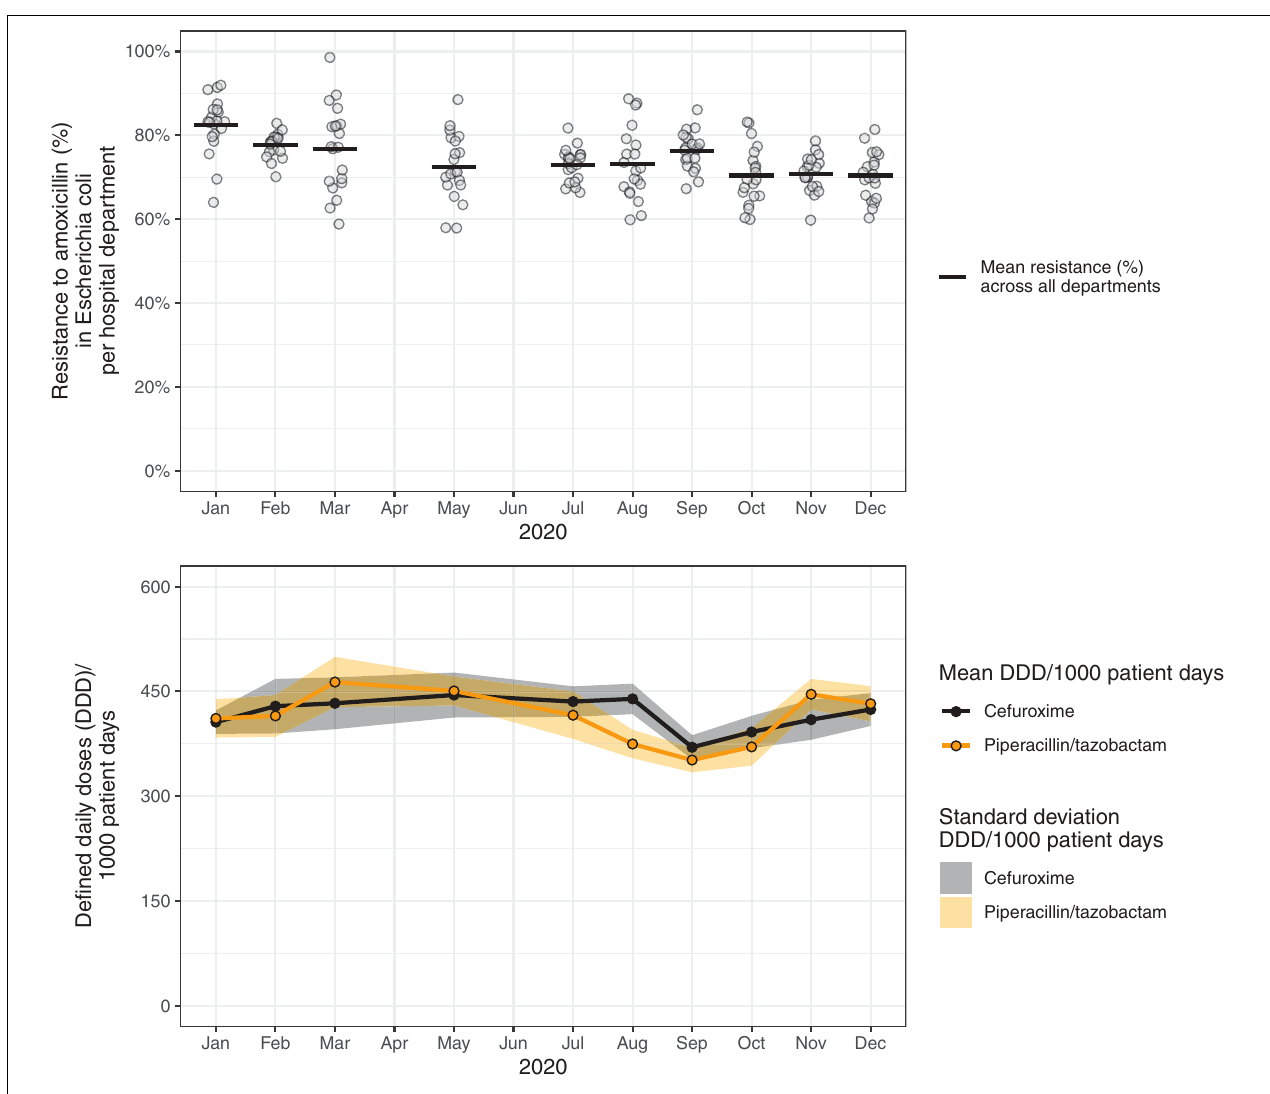
FIGURE 5 | Resistance to amoxicillin in Escherichia coli and consumption of cefuroxime and piperacillin/tazobactam across hospital departments in 2020. These data visualizations use the same data as in Figure 4 (simulated data), but propose an improved visualization.